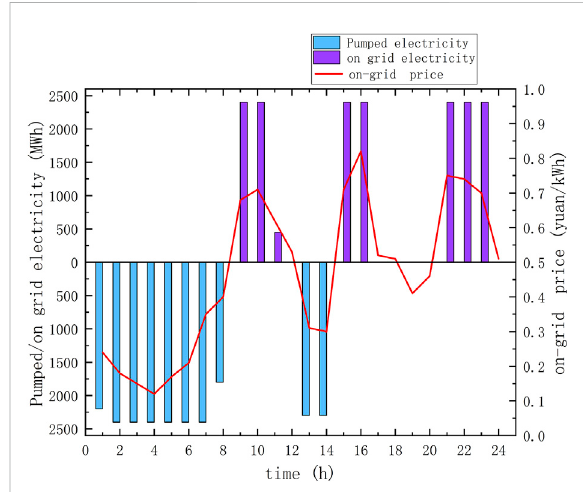
FIGURE 4 Optimal operation of PSPP that both participate in electric energy and ancillary services spot market in scenario